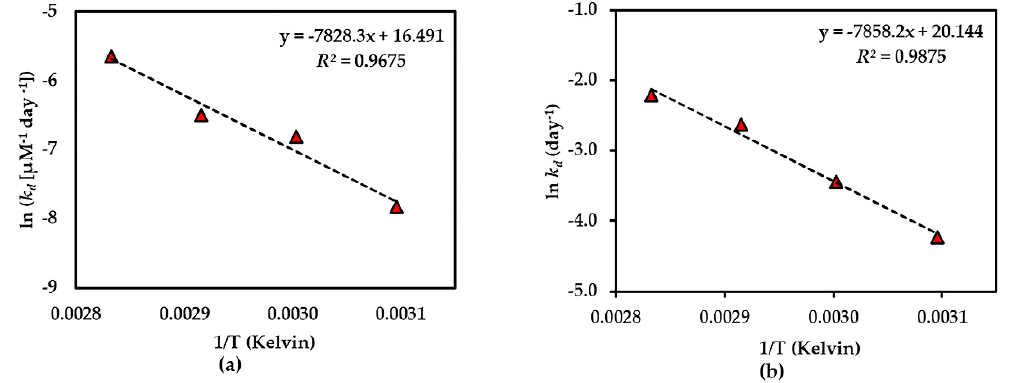
Figure 6. Arrhenius plot for thermal degradations of compound 2 in ( a ) dried AE and ( b ) AE solution over the temperature range 40 °C–70 °C. The plotted points are mean ± SD ( n = 3).